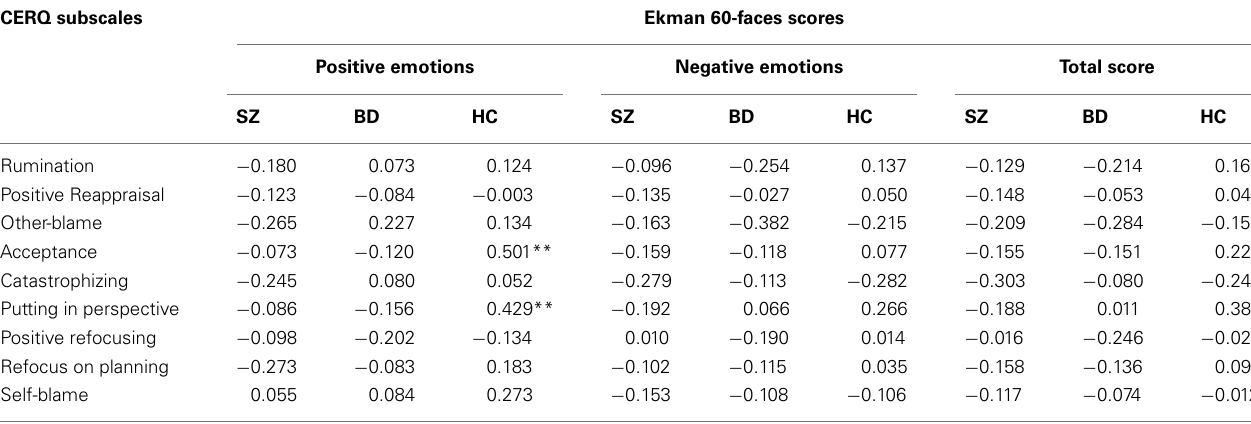
Table 4 | Pearson’s two-tailed correlations between Ekman scores and CERQ strategies for SZ, BD, and HC groups. CERQ